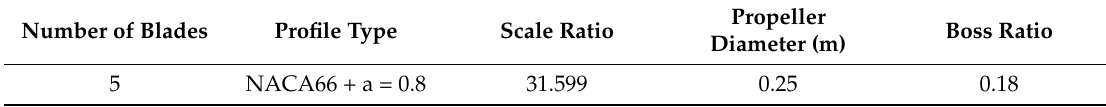
Table 2. Main parameters of the KP505 propeller model.